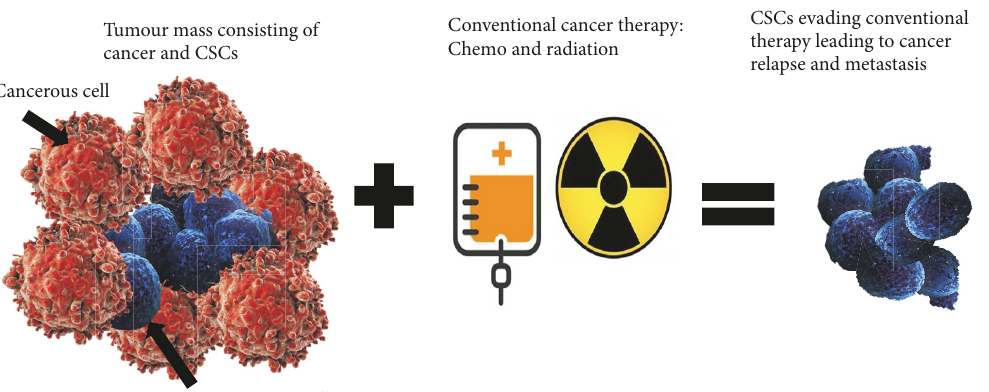
Figure 1: CSCs and conventional cancer therapy. Chemo- and radiation therapy fail to eradicate CSCs, which can lead to cancer relapse and